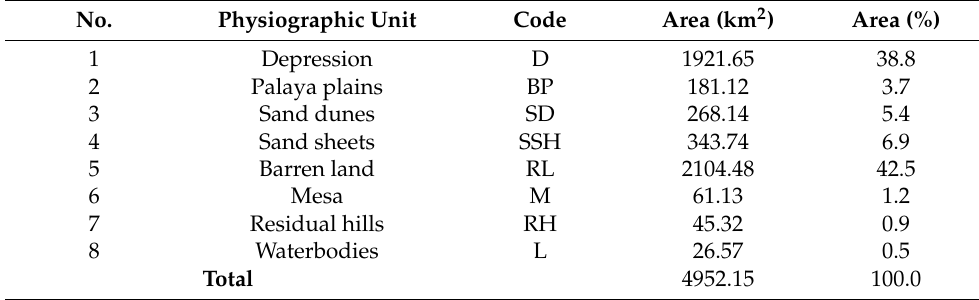
tem. = temperature. Table 2. The physiographic units of the study